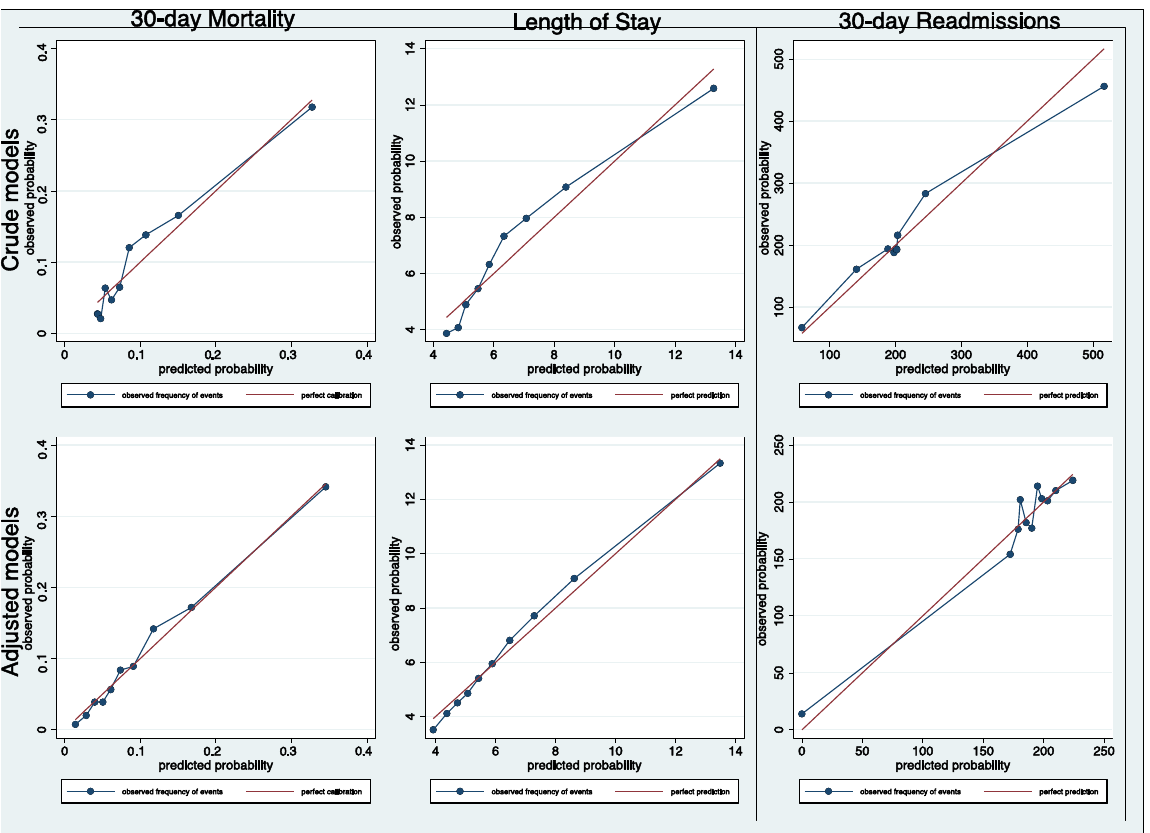
Figure 2. Calibration assessment after multilevel mixed logistic regression models for 30-day mortal- ity, length of stay and 30-day readmissions.